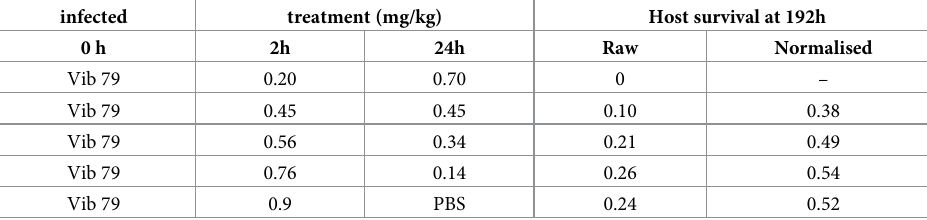
Table 3. Host survival from the biological validation experiments. Host survival was recorded at 192 h for five dif- ferent antibiotic treatment regimens, with both the ‘raw’ data given, along with the ‘normalised’ data, whereby host sur- vival for four of the treatments were increased by 0.28 to bring host survival for (0.45,0.45) and (0.9,0) treatments in line with those in the initial experiments, in Table 2. (n = 90.) Full data in the Supporting Information (S3